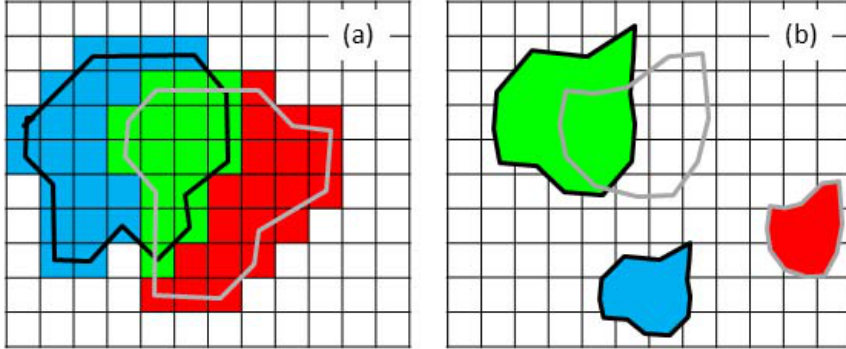
Fig. 5. Lightning (black) and Cb-TRAM (grey) objects. (a) Pixel-based analysis: the pixels covered by the lightning and the Cb-TRAM objects are counted. (b) Object-based analysis: the lightning and the Cb-TRAM objects are counted. Green are the hits, blue the misses, and red the false alarms (adapted from Forster and Tafferner,